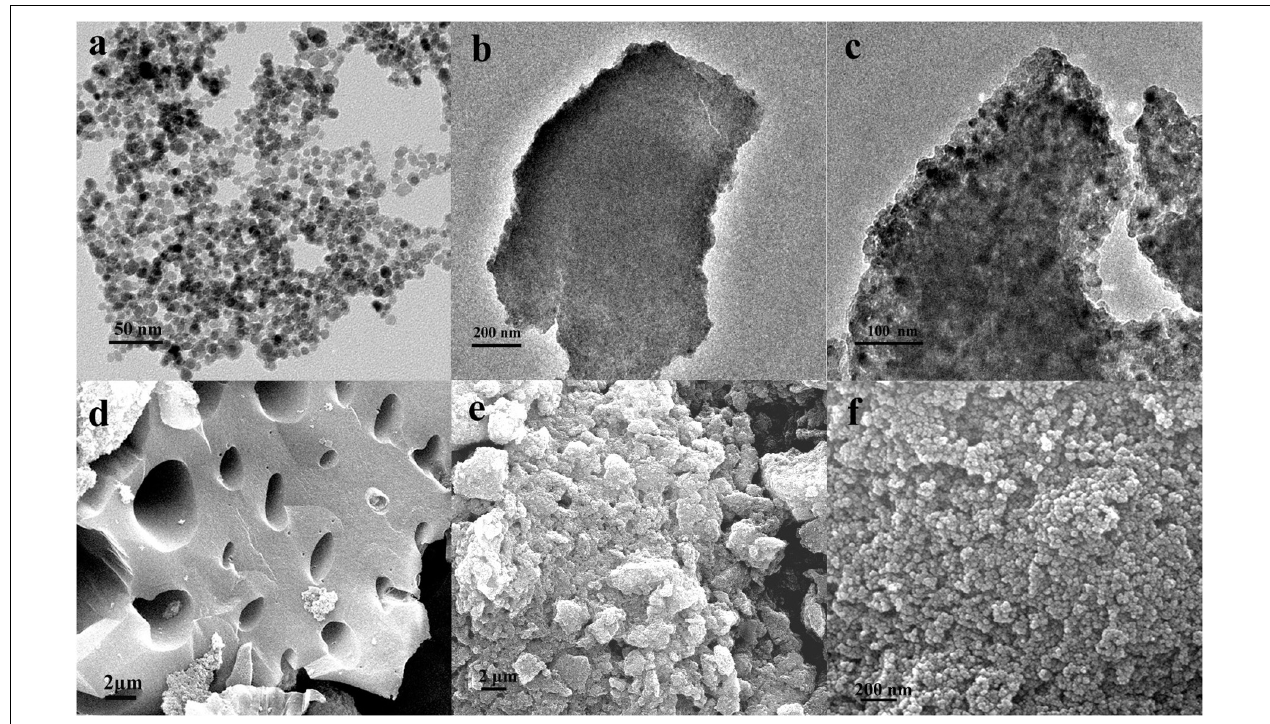
FIGURE 3 | TEM micrographs of (a) Fe 3 O 4 nanoparticles (NPs), (b) biochar, and (c) Fe 3 O 4 /biochar, SEM images of (d) biochar, (e) Fe 3 O 4 /biochar, and (f) magnified SEM image of Fe 3 O 4 /biochar.